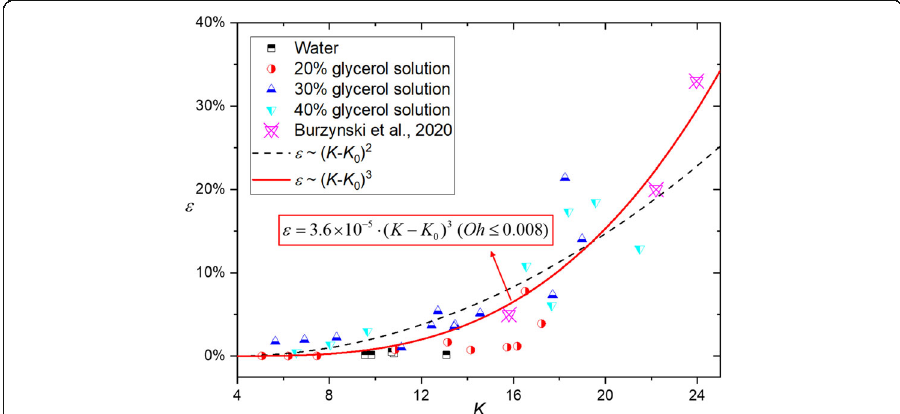
Fig. 7 Relation between the total splashing volume ε and the splashing threshold K . Different symbols represent the experimental data using different kinds of liquid. The black dotted line shows the fitting curve using ε ~ ( K − K 0 ) 2 (R-squared value = 0.74), and the red solid line shows the fitting curve using ε ~ ( K − K 3 (R-squared value = 0.81), which is more reasonable for the 0 )